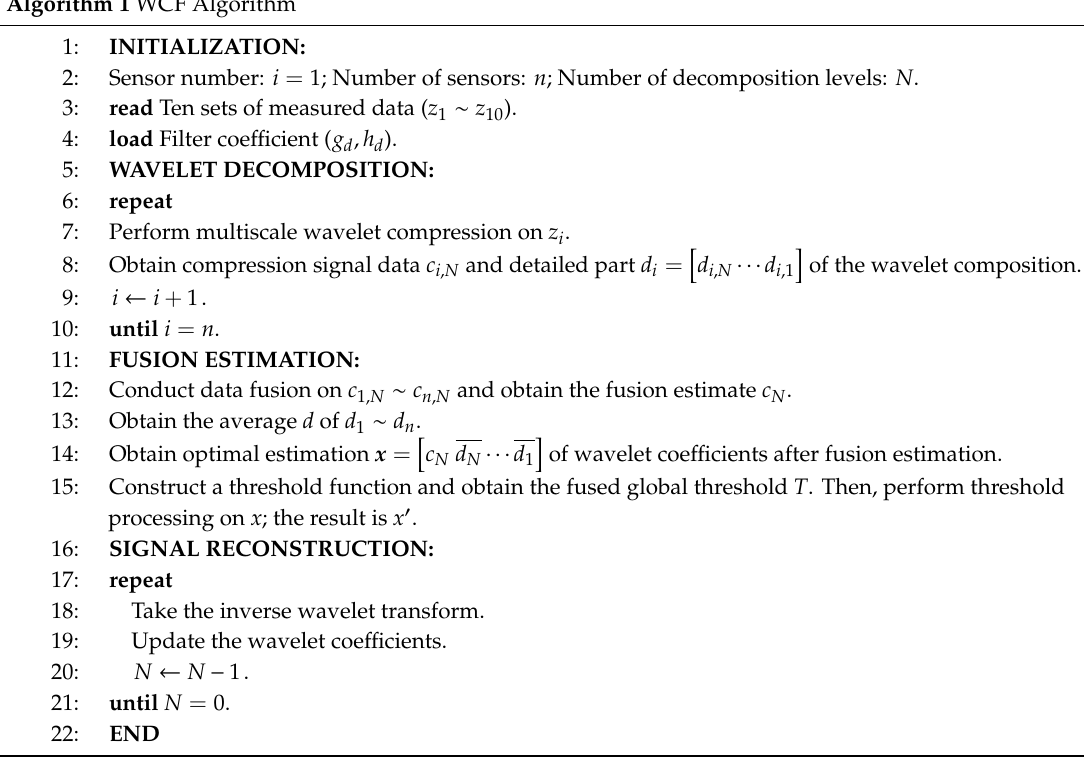
Algorithm 1 WCF Algorithm